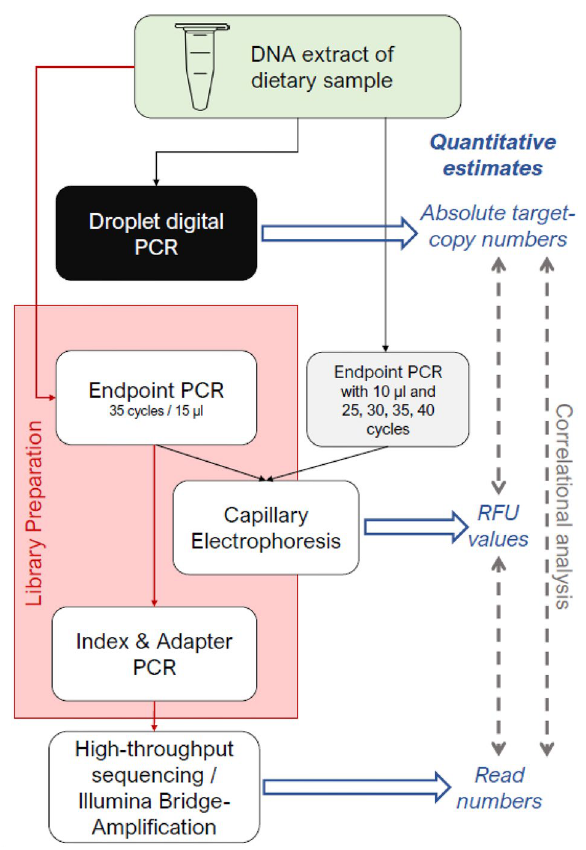
Figure 5. Flow diagram of analysis methods used on regurgitate samples of Pseudoophonus rufipes to get absolute and relative estimates of copy/read numbers contained in DNA extracts, PCR products and metabarcoding libraries. Measures of target DNA estimates at different analysis steps are indicated in